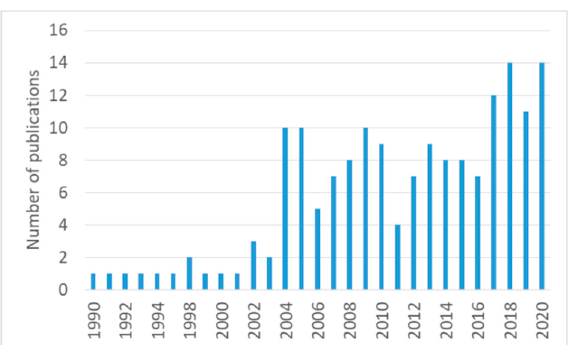
Figure 1. Number of publications referring to the topic coronaviruses and (Climate or Water or Soil or Ecosystems), retrieved on 30 April 2020. The statistics includes studies tackling the bidirectional relation between all types of coronaviruses and the mentioned environmental components. Data source: Web of Science.